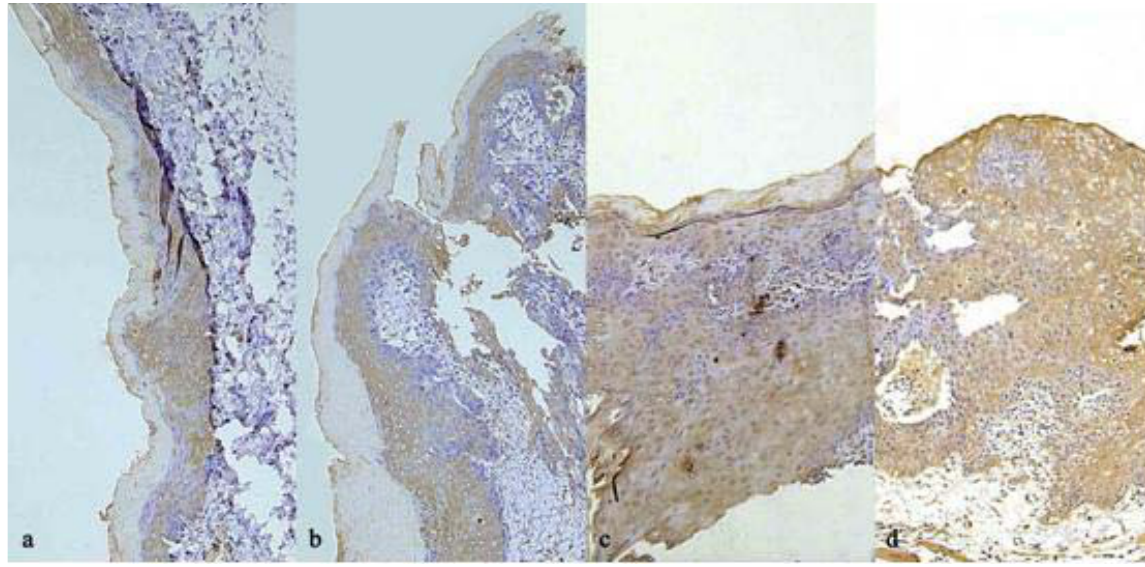
Comparison of rates of two samples for intra-group comparison, and rank-sum test for inter-group comparison. Each roman number represent the number of samples. Figure 5. Tissue sections at 9 weeks corresponds caspase-3 immunostaining. ( a ). Dysplasia epithelium in the Treatment Group; ( b ). Dysplasia epithelium in the Model Group; ( c ). Squamous cell carcinoma the Treatment Group; ( d ). Squamous cell carcinoma epithelium in the Model